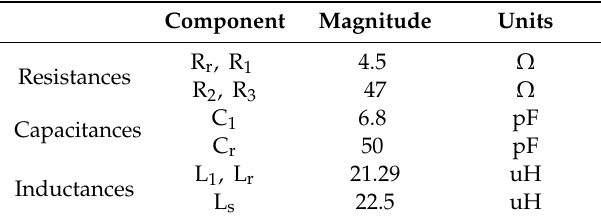
Table 4. Values of the bridge circuit components.